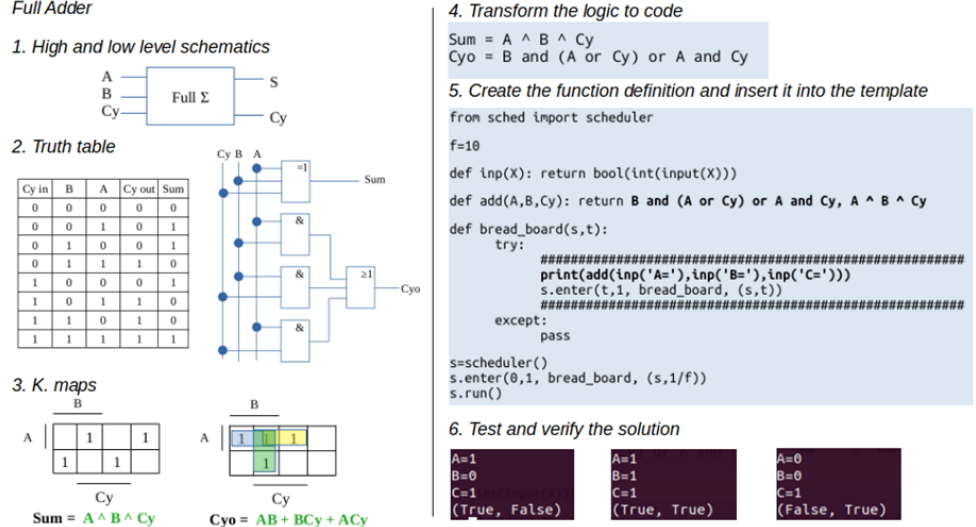
Figure 7. Illustration of the steps to be taken during the combinational logic training in experimen- tal